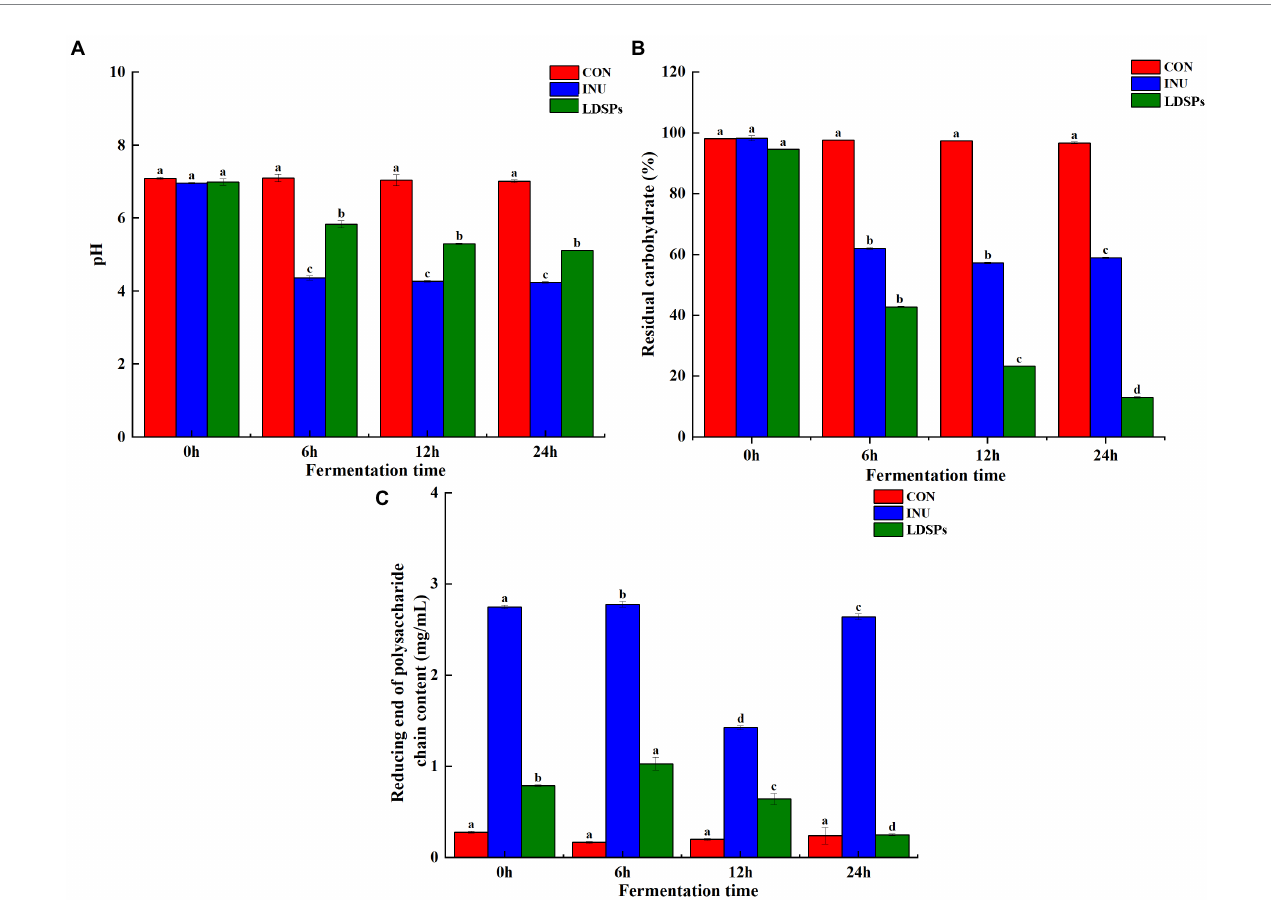
FIGURE 1 pH value (A) , residual carbohydrate (B) , and reducing end of polysaccharide chain content (C) during in vitro fermentation, respectively. Data are expressed as mean ± SD ( n = 5), and a–d mean significantly different ( p < 0.05) by a Tukey test in the same group with different time